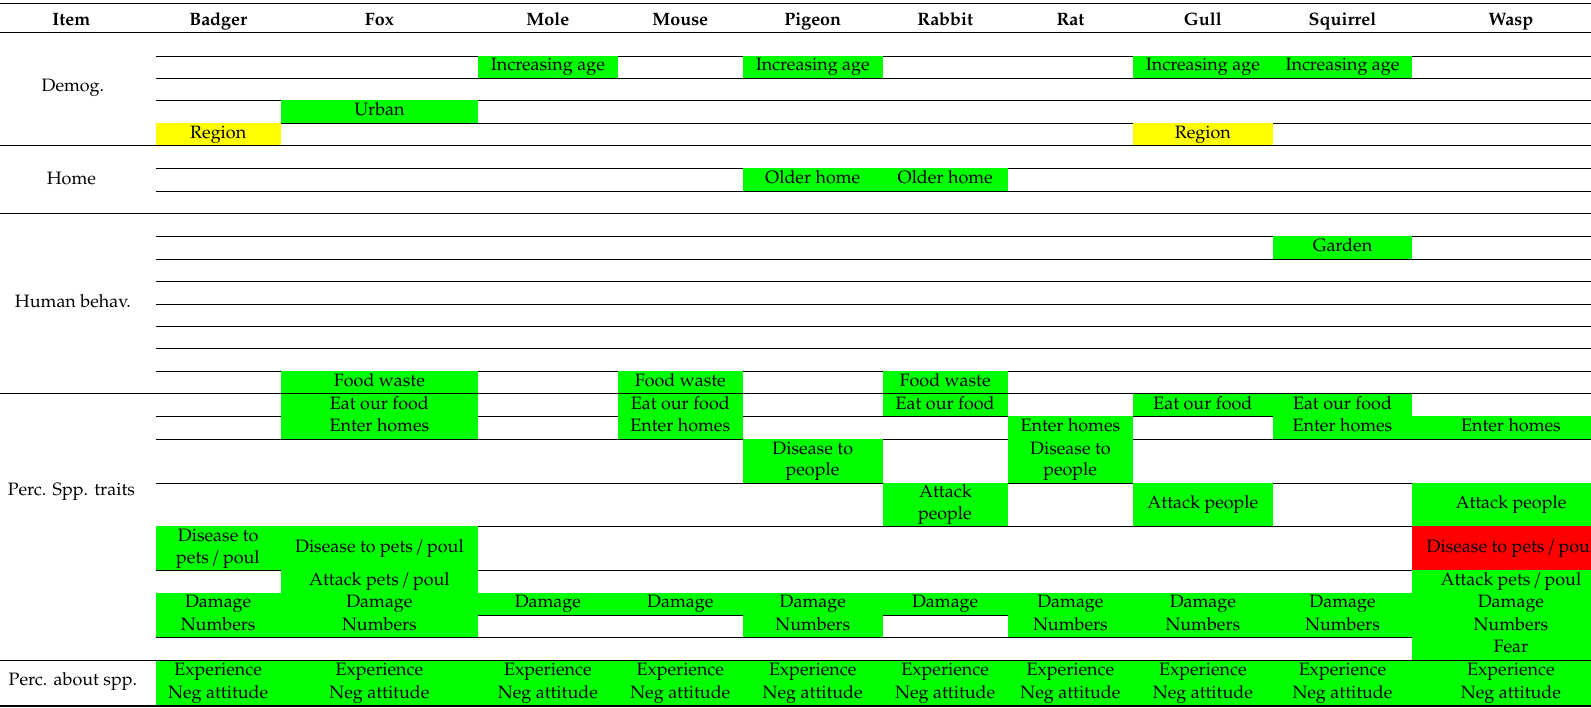
Table 6. Factors associated with people’s beliefs about 10 species causing problems for people generally in the UK ( n = 1828). Factors are grouped under: Demog. = ‘Demography’, Home = ‘Home’, Human behav. = ‘Human behaviour’, Perc. spp. traits = ‘Perceived species traits’, and Perc. about spp. = ‘Perceptions about species’. Factors shown in red were associated with a lower likelihood of believing species cause problems generally, those shown in green were associated with a greater likelihood, and those shown in yellow were associated with a more complex e ff ect. See the list of abbreviations for factors in Supplementary Materials Table S2. Item Badger Fox Mole Mouse Pigeon Rabbit Rat Gull Squirrel Wasp Increasing age Increasing age Increasing age Increasing age Demog. Urban Region Region Home Older home Older